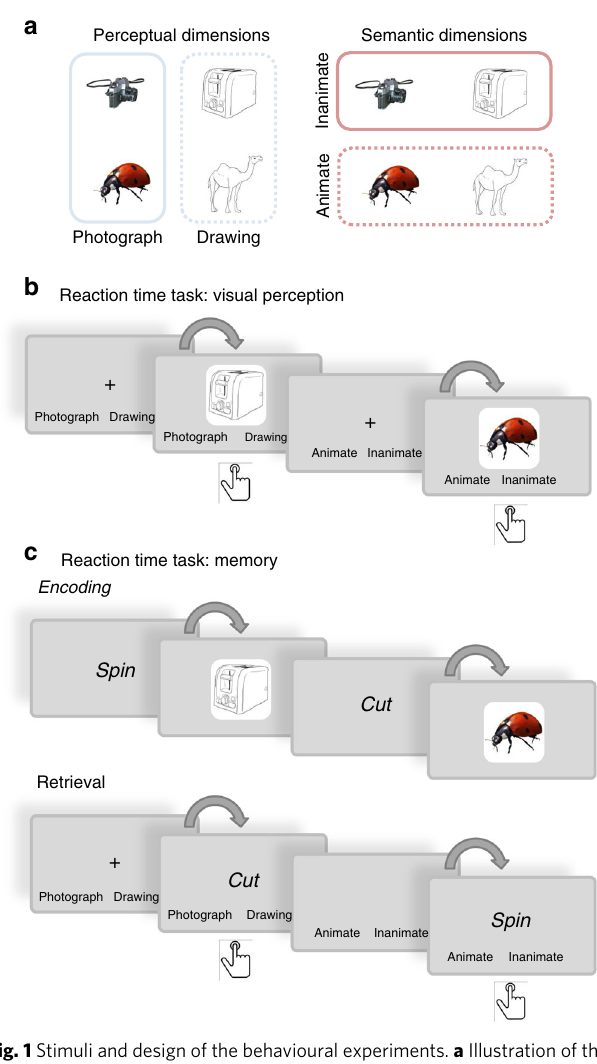
Fig. 1 Stimuli and design of the behavioural experiments. a Illustration of the orthogonal design of the stimulus set. In all experiments, objects (a total of 128) varied along two dimensions: a perceptual dimension where objects could be presented as a photograph or as a line drawing; and a semantic dimension where objects could belong to the animate or inanimate category. b In the visual reaction time task, participants were prompted on each trial to categorise the upcoming object as fast as possible, either according to its perceptual category (photograph vs. line drawing) or its semantic category (animate vs. inanimate). c During the encoding phase of a memory reaction time task, participants were asked to create word-object associations (a total of eight per block). Reaction times were then measured during the retrieval phase, where subjects were presented with a reminder word, and asked to recall and categorise the associated object according to its perceptual (photograph vs. line drawing) or semantic (animate vs. inanimate) features. Button press symbols indicate at